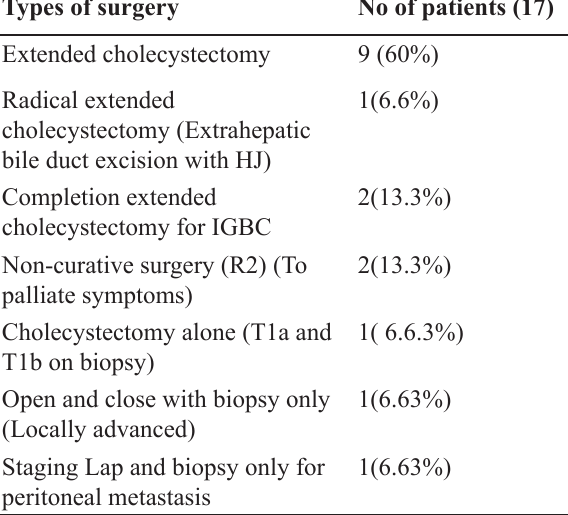
Table 2: Types of surgery Types of